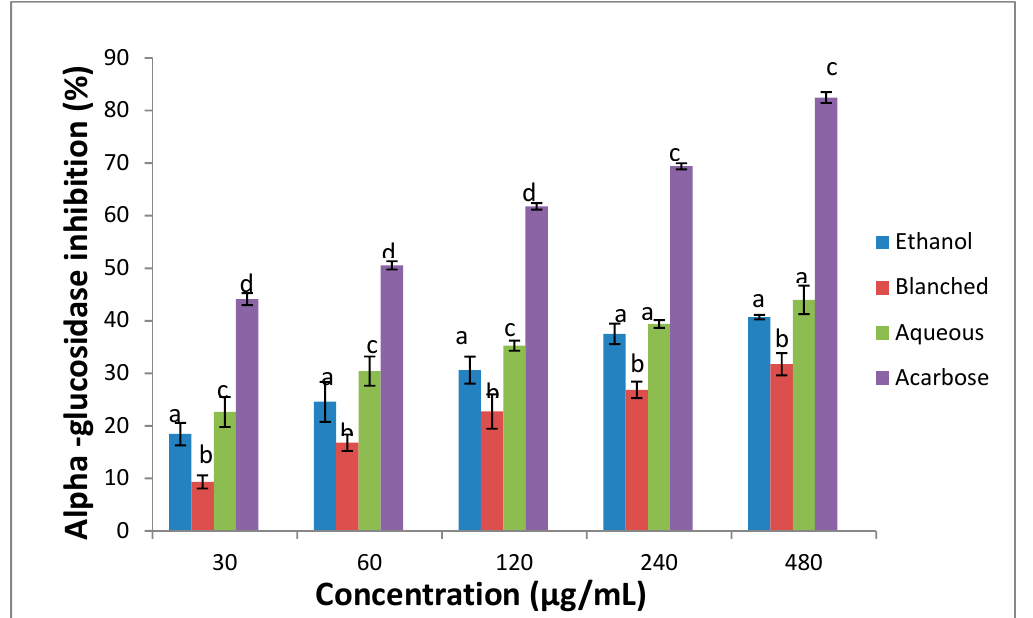
Figure 5. Alpha-glucosidase inhibitory activity of H. arborescens leaf extracts and positive control (acarbose). Values are expressed as mean ± SD ( n = 3). Mean separation by SD ( p < 0.05). Bars at the same concentration with different alphabets are significantly different.